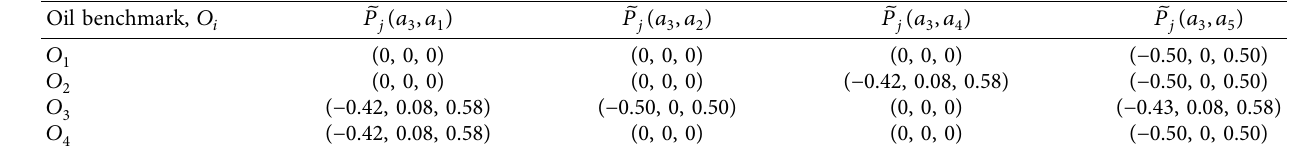
Table 11: Fuzzy preference function, 􏽥 P